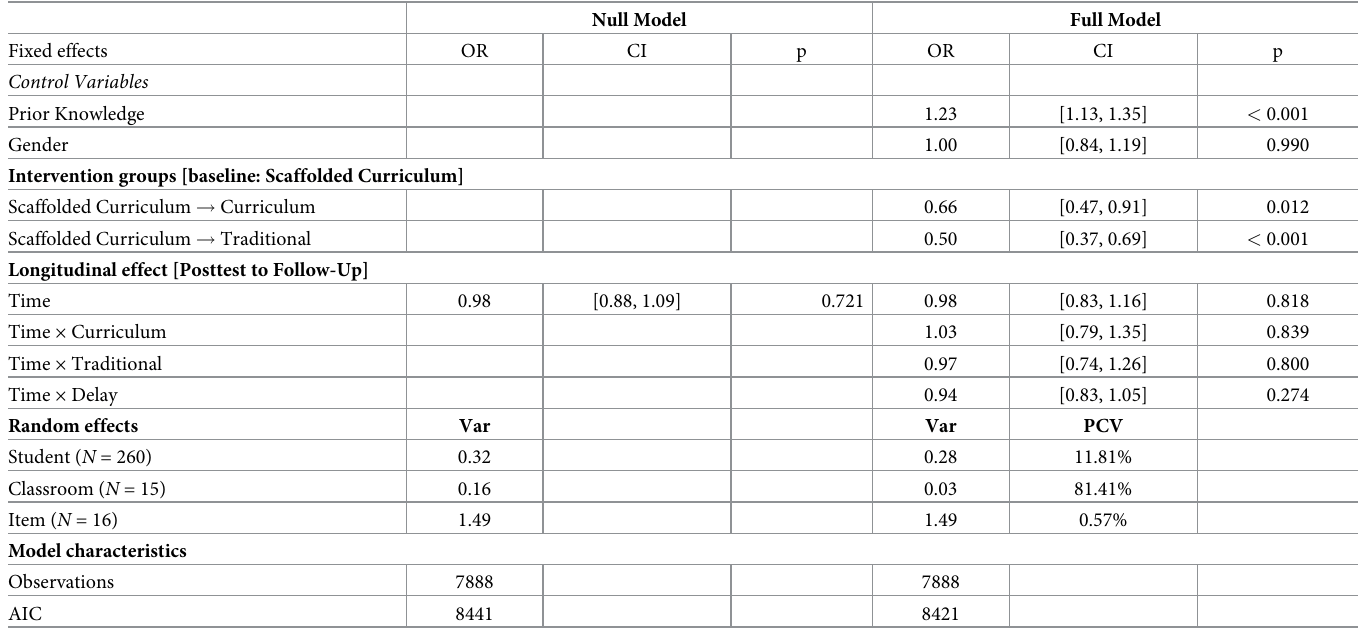
Table 3. Estimates of the generalized linear mixed models used to predict the likelihood for a correct answer in the posttest and the follow-up.